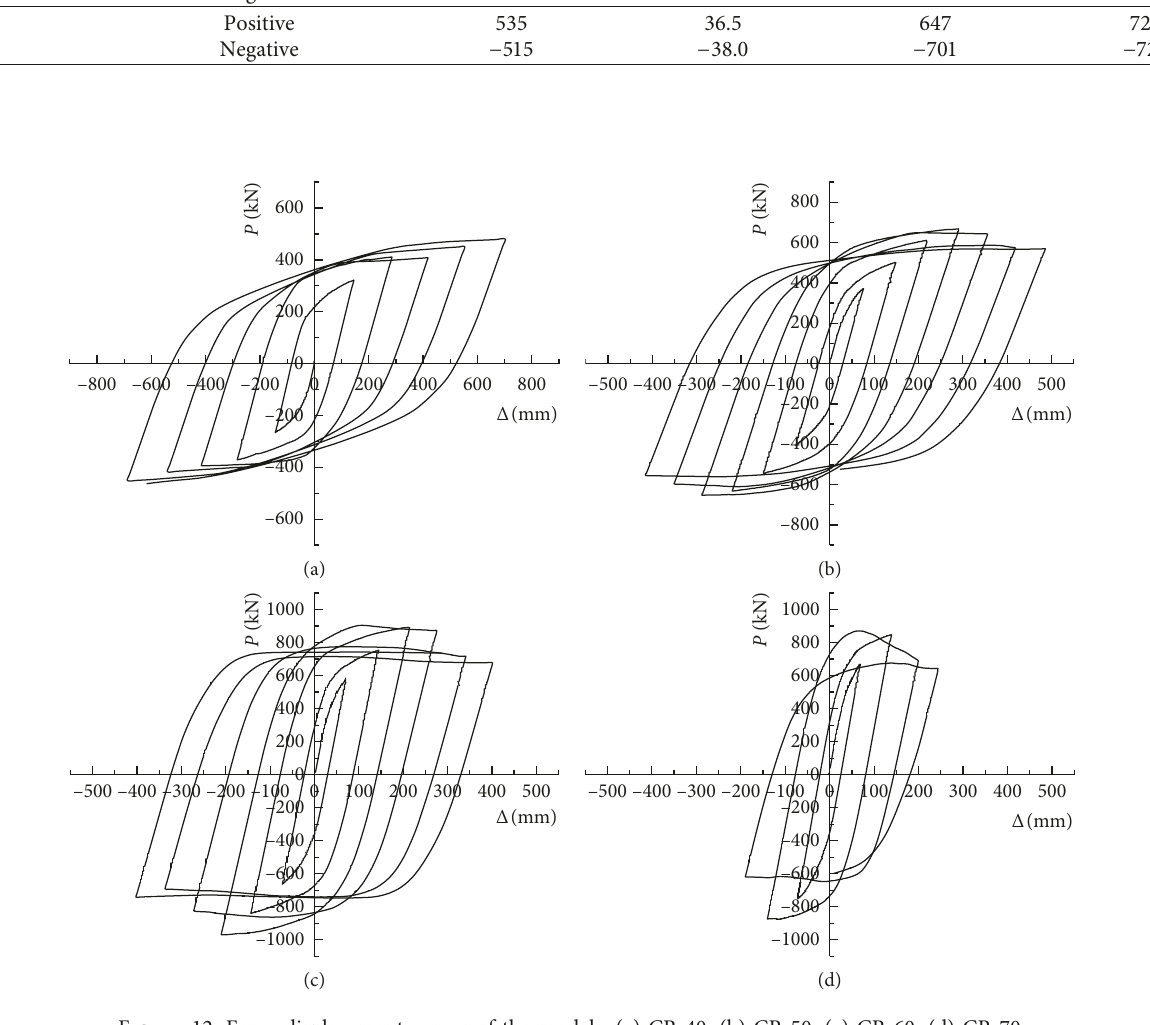
Figure 12: Force-displacement curves of the models. (a) CR-40. (b) CR-50. (c) CR-60. (d)